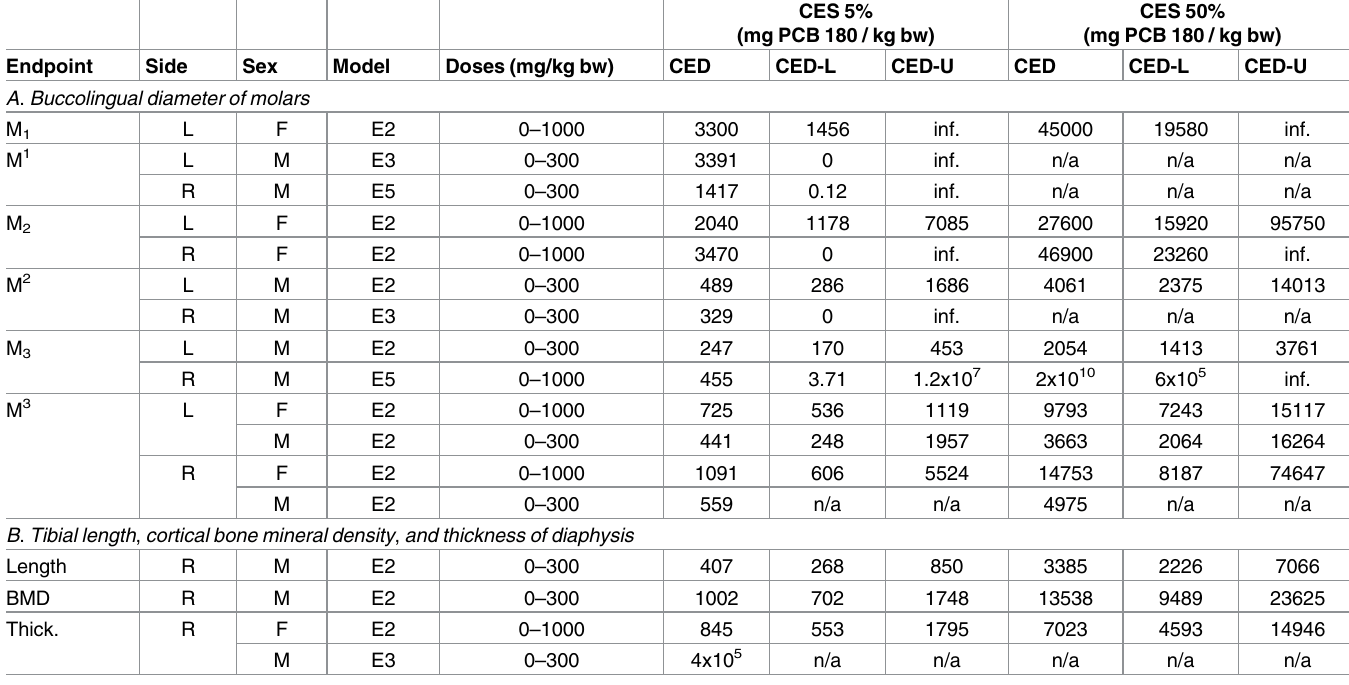
Table 7. Results of benchmark dose modeling showing significant PCB 180 dose-responses of tooth size (maximum buccolingual diameter) for all molars (A) and of tibial length, cortical bone mineral density, and thickness of diaphysis (B) on PND 84. Critical effect doses (mg/kg bw) and their lower and upper boundsof the 95% confidenceintervals are shown for critical effect sizes of 5% and